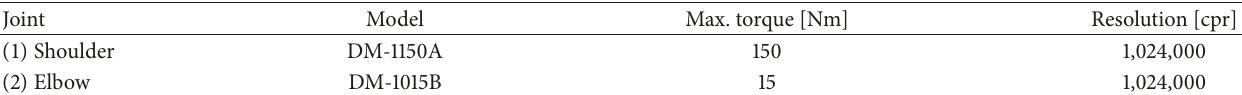
Figure 2: Experimental results for the PD control f 𝜒 Table 1: Robot arm servo